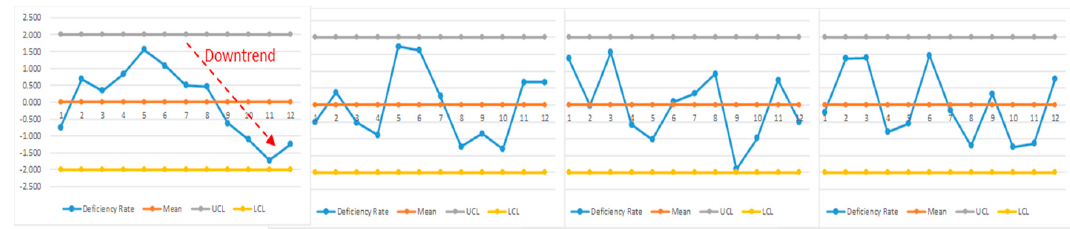
Figure 15. The control chart for deficiency 13 (2015–2018).